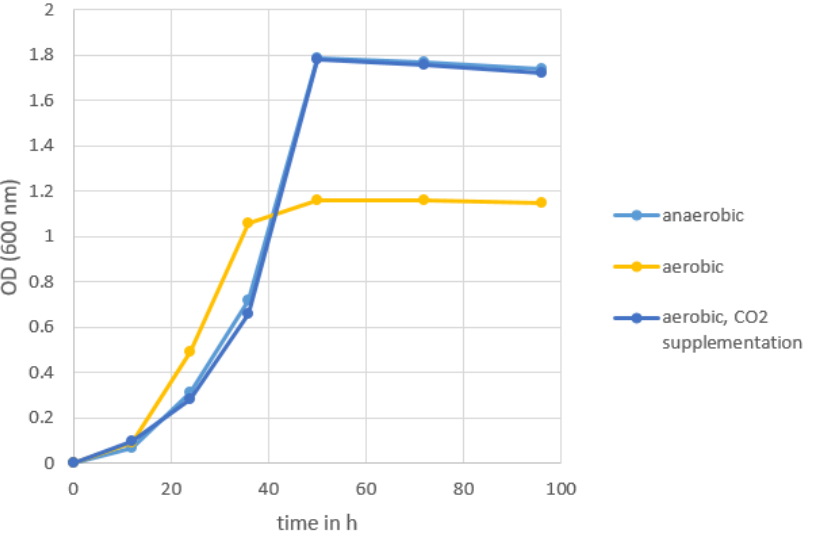
Figure 3. Growth of S. saccharolyticus in BHCY medium under different conditions. Light blue, anaerobic atmosphere (Oxoid-AnaeroGen system); dark blue, CO 2 -rich atmosphere (Oxoid-CO 2 Gen system; generating ca. 6% CO 2 , ca. 15% O 2 ); yellow, aerobic atmosphere. The experiment was replicated twice.